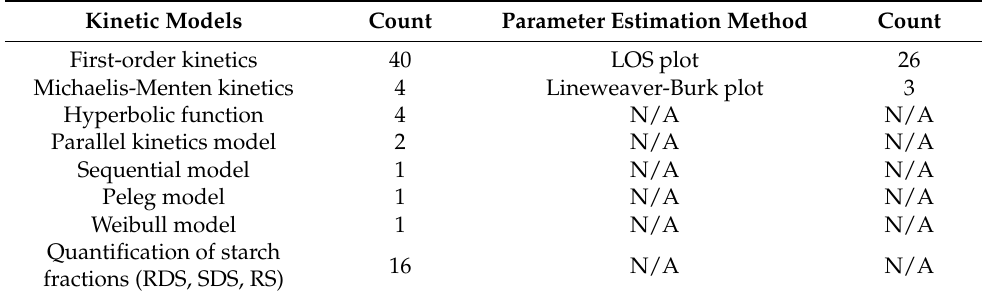
Table 5. Kinetic models and the corresponding kinetic estimations for selected